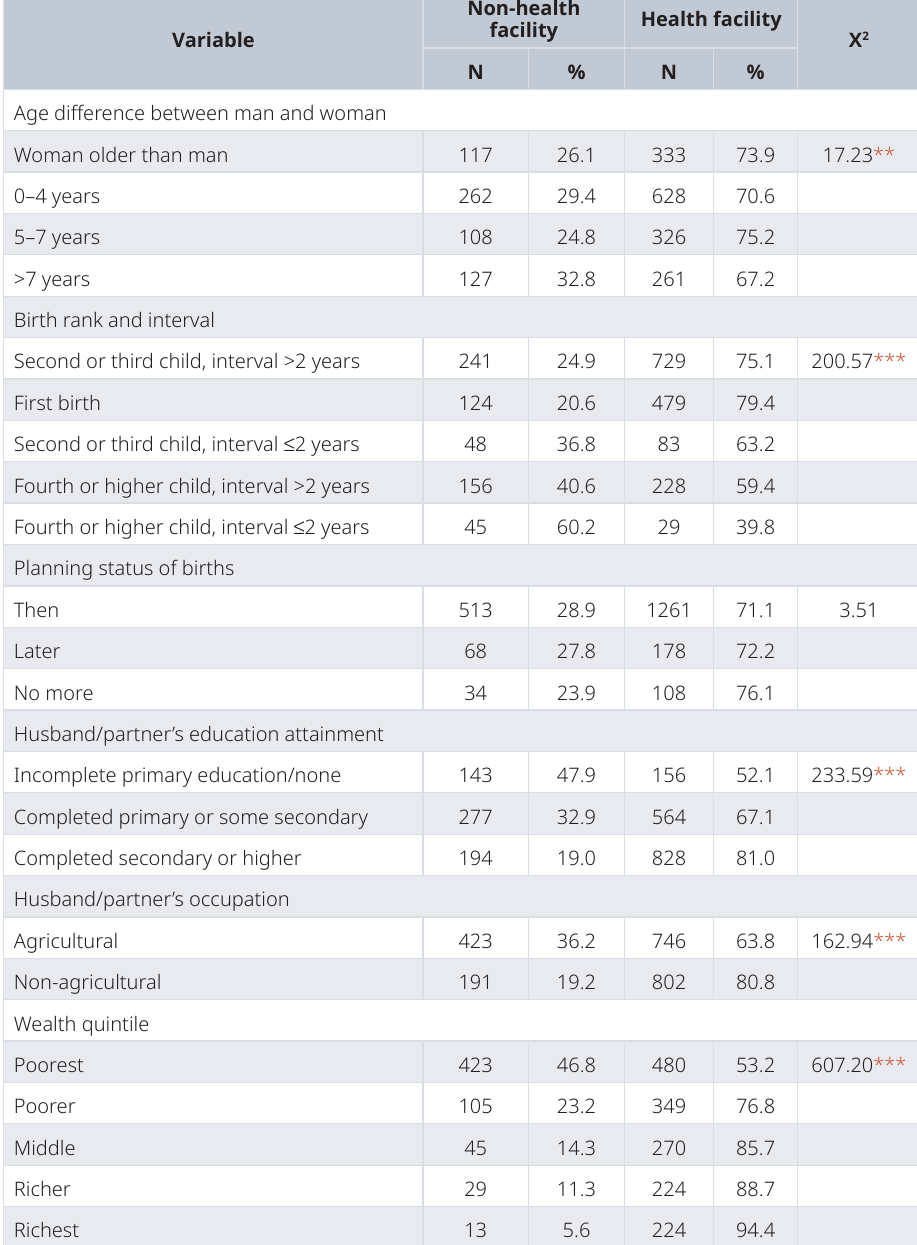
Table 2. Bivariate analysis of women’s characteristics and place of delivery